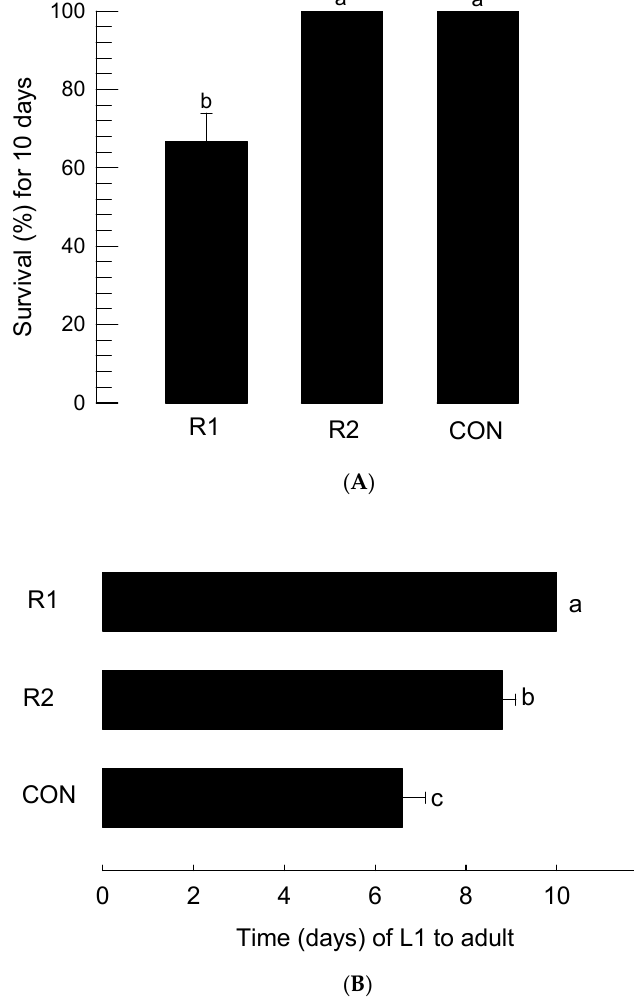
Figure 5. Influences of different varieties of hot peppers on the immature development of F. occidentalis . ‘R1’ and ‘R2’ are varieties resistant to TSWV infection. ‘CON’ represents the control based on the soybean diet. Leaf disks of the hot peppers were used for the feeding treatment of the thrips larvae. ( A ) Survival rate after feeding treatment for 10 days. Each treatment used 30 larvae and was replicated three times. ( B ) Changes in the immature developmental period from egg hatching (L1) to adult emergence by the feeding treatments. Each treatment used 20 individuals to measure their developmental periods. The letters above the standard deviation bars indicate significant differences among the means at type I error = 0.05 (LSD